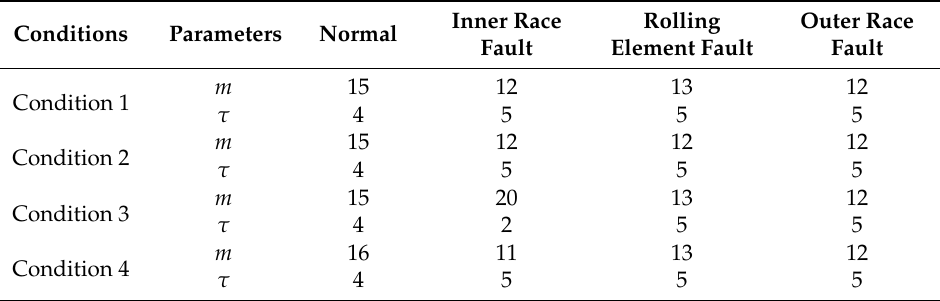
Table 2. The experiment parameters of each fault mode under different